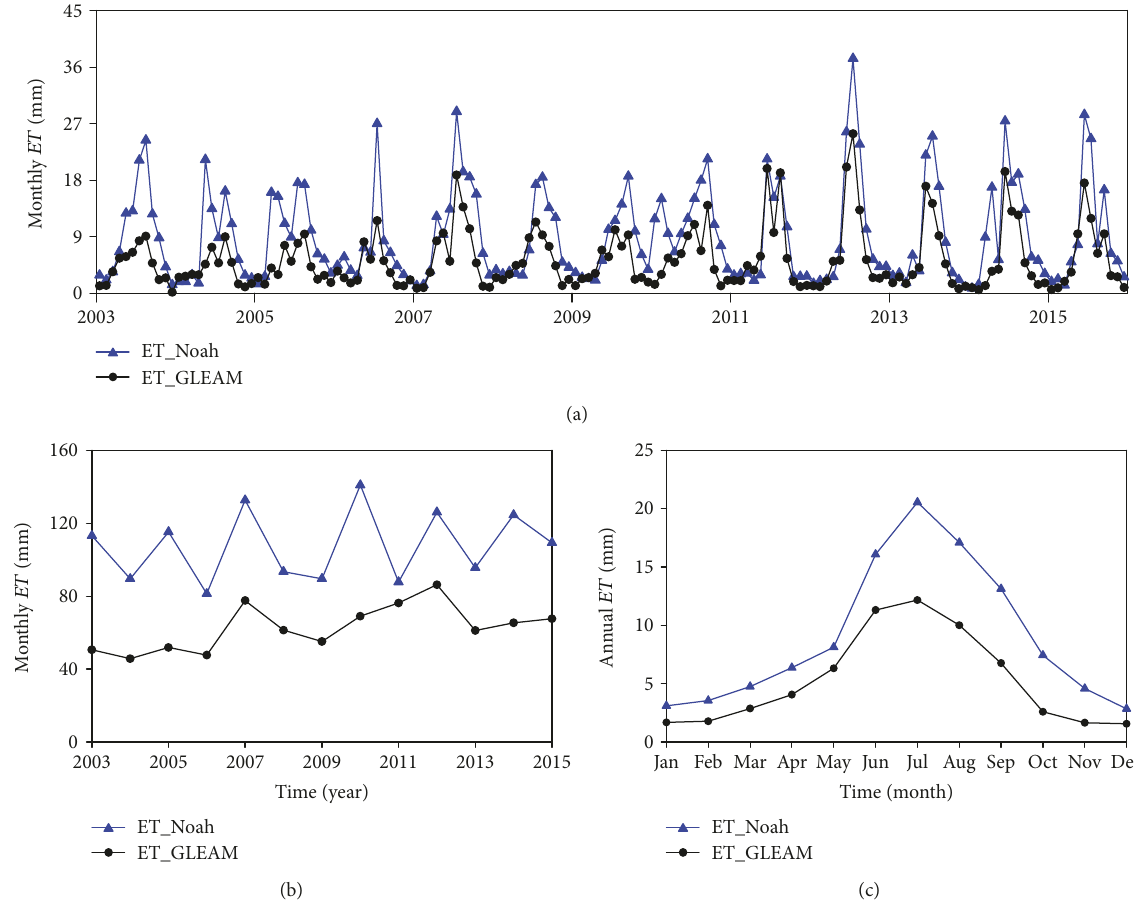
Figure 6: The 2003-2015 (a) monthly time series, (b) annual time series, and (c) mean seasonal cycles of ET from four GLDAS Noah model and remote sensing-based products